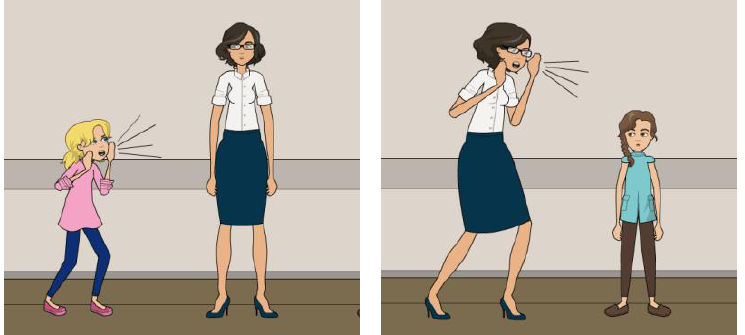
Figure 1. Example trial for the actional verb gritar ‘yell’, match condition